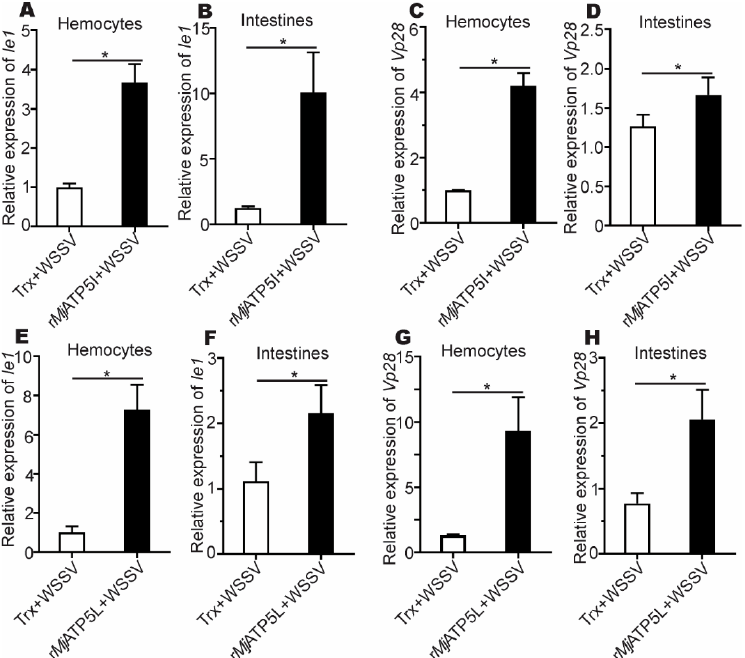
Figure 5. The relative expression of Ie1 and Vp28 gene after recombinant protein injection. ( A – D ) The expression of Ie1 ( A , B ) and Vp28 ( C , D ) in hemocytes and intestines after r Mj ATP5I injection. ( E – H ) The expression of Ie1 ( E , F ) and Vp28 ( G , H ) in hemocytes and intestines after r Mj ATP5L injec- tion. The results are expressed as the mean ± SD and significant differences were analyzed between